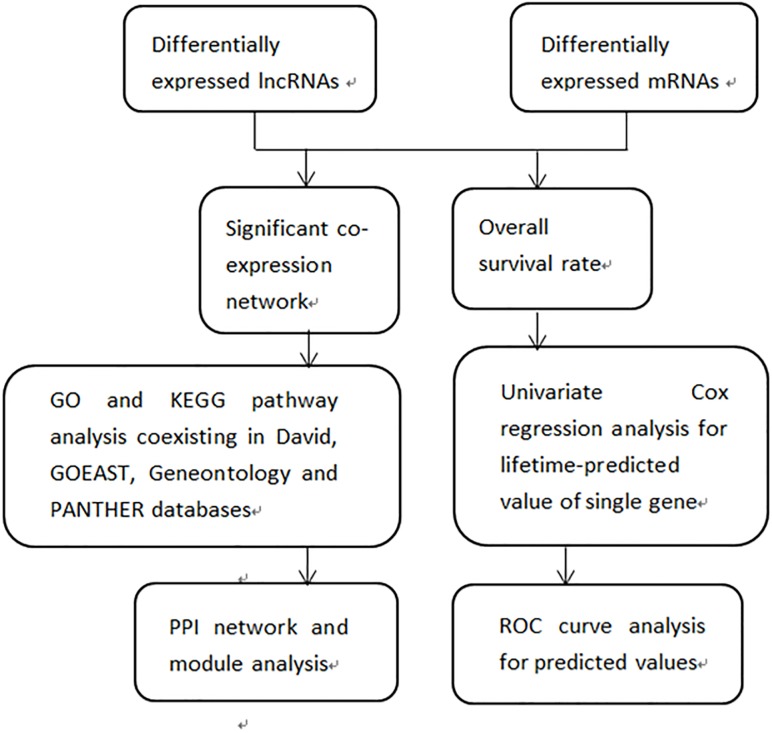
Flow diagram of the study design. DElncRNAs and DEmRNAs were investigated between 103 primary and 368 metastatic melanomas (log2fold change > 2, FDR < 0.01)